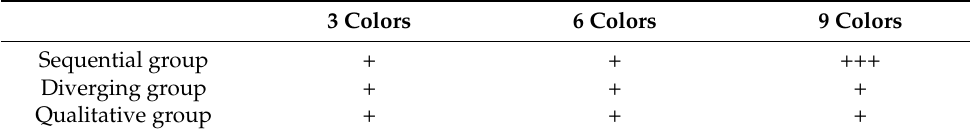
Table 2. The number of questionnaire items per factor.